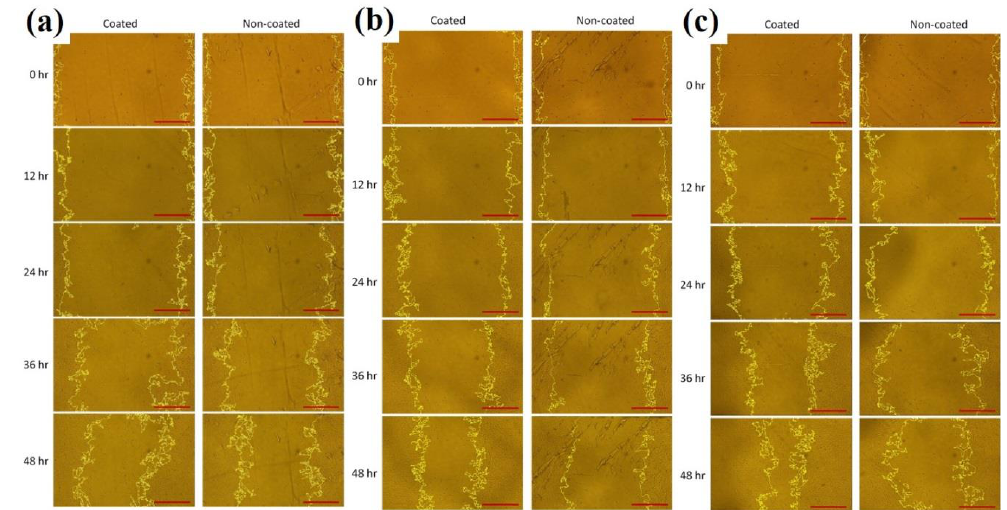
Figure 7. Images of the wounds at different time points after removing the barrier. ( a ) PBS-coated and uncoated surfaces. ( b ) Poly-L-lysine-coated and uncoated surfaces. ( c ) Gelatin-coated and uncoated surfaces. Scale bar = 500 μm.